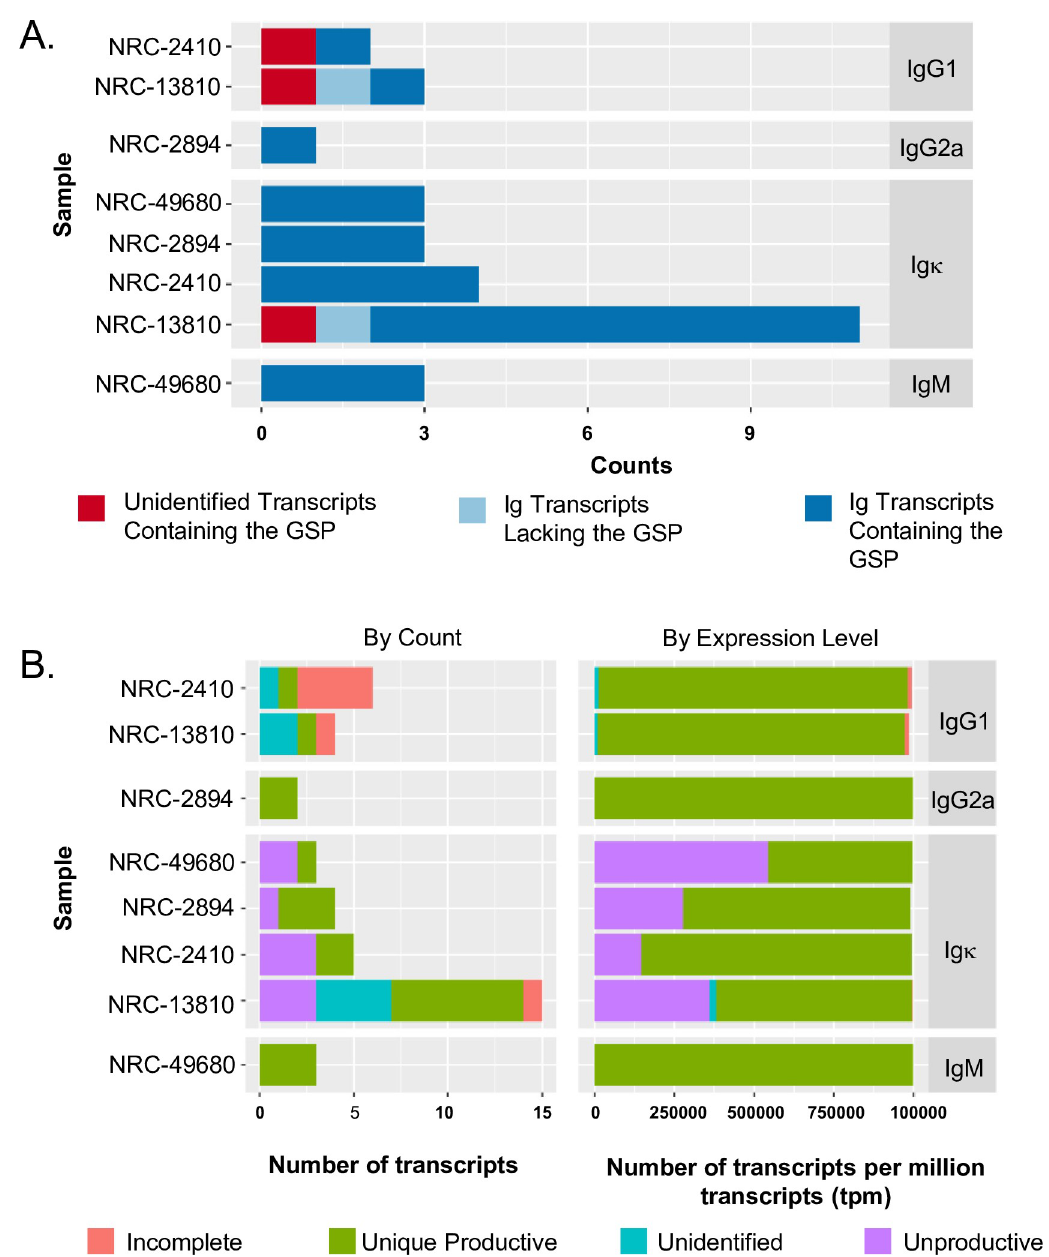
Fig 2. Hybridoma Ig sequencing using MiSeq Illumina NGS and de novo transcript assembly. Profiles of Contig types among the 4 hybridomas. A . Summary of hybridoma sequence contig assemblies identified using isotype-specific ISPs. B. The Trinity de novo assembled Ig contigs were grouped and quantitated based on counts (Left) or expression levels (Right) into four functional categories: 1) Unique Productive—contigs without STOP codons in the CDRs and found in only one of the tested hybridomas, 2) Unproductive—contigs with one or more STOP codons in the CDRs, 3) Incomplete—only 1 or 2 CDRs identified, and 4) Unidentified—no CDRs identified. common IgG2a κ –Fc cloning vector, implying antigen-binding prior to and following isotype- switching, if done correctly, should be similar in specificity and affinity. The supernatant of Day-6 post-transfection rAb NRC-2894 cells was collected. Both recombinant and hybridoma secreted antibodies were highly purified ( Figs 3D and S3B and S4B ). The rAb NRC-2894